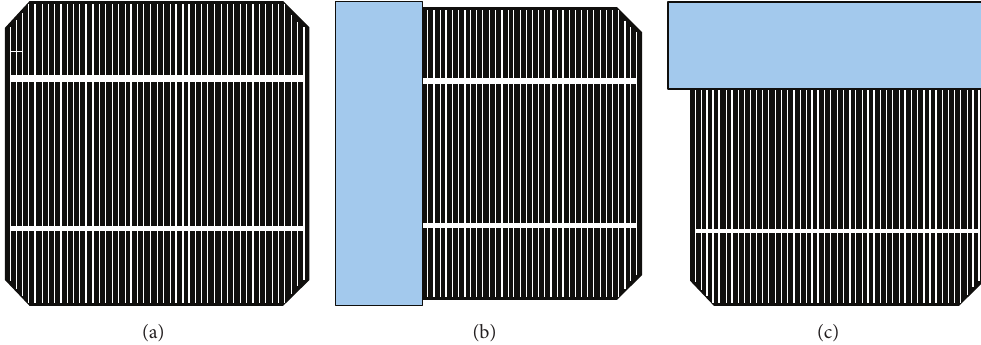
Figure 1: Illustration of intensity illumination profiles (a) uniform illumination, (b) nonuniform illumination along the grids of the PV cell, and (c) nonuniform illumination across the grids of the cell.